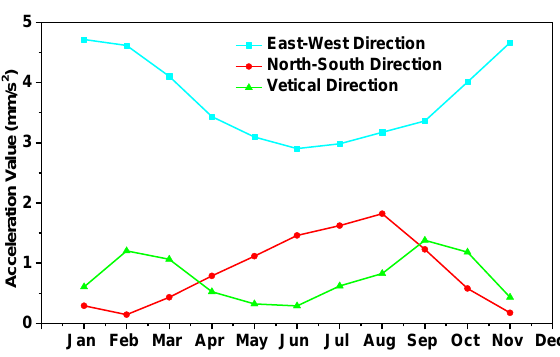
Figure 7. Monthly vibration acceleration in 2016(mm/s 2 )